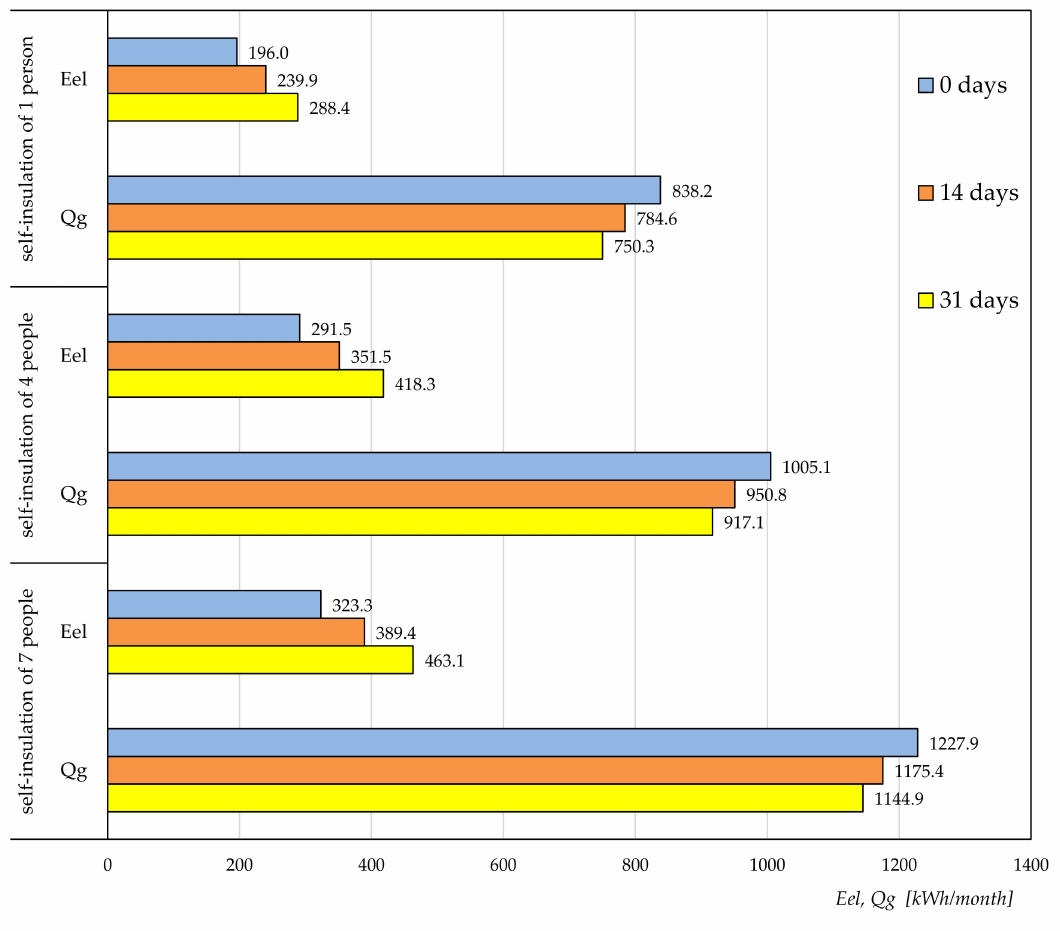
Figure 14. Change in the structure of energy used in the building: electricity E el and energy from fuel (gas) Q g